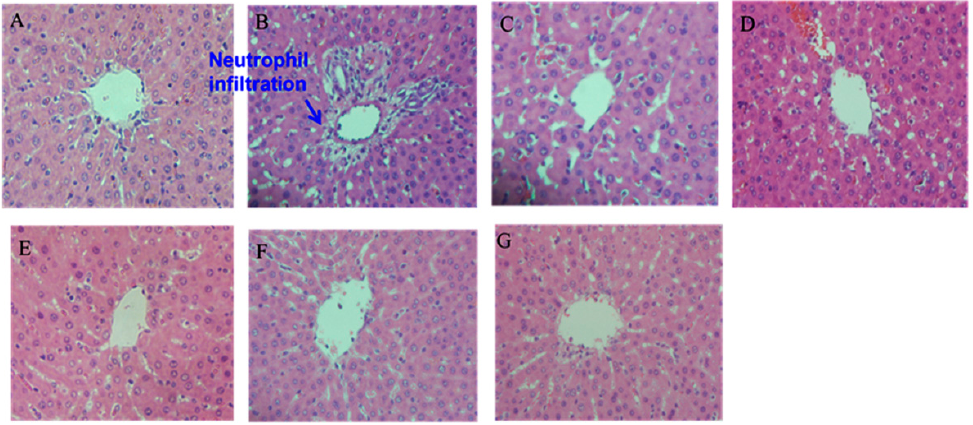
Figure 4. Histopathologic sections of liver tissues of control group ( A ); LPS group ( B ); LPS + NAC (200 mg/kg) ( C ); LPS + AST (10 mg/kg) ( D ); LPS + LA (2 mg/kg) ( E ); LPS + LA (5 mg/kg) ( F ); LPS + LA (10 mg/kg) ( G ). Magnification 400×.